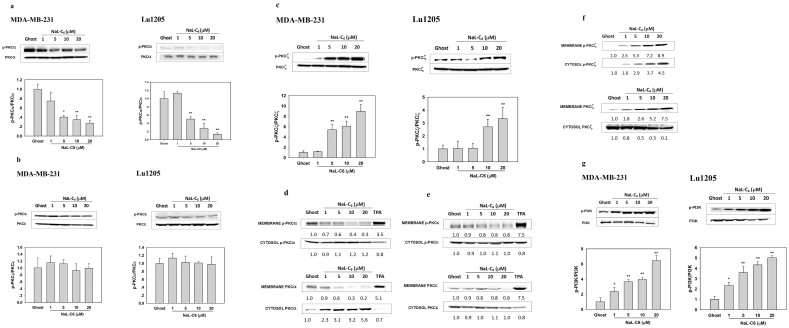
Nanoliposomal C6-ceramide induced phosphorylation of PKCζ nd PI3K as well as dephosphorylation of PKCα in a dose-dependent manner.(a–c) PKCζ was phosphorylated in response to acute NaL-C6-ceramide treatment. 1 μM, 5 μM, 10 μM or 20 μM NaL-C6 or ghost nanoliposomes were incubated with 1 × 106 MDA-MB-231 or Lu1205 cells for 30 min. Then, the cells were subject to western blotting analysis of (a) PKCα, (b)PKCε, and (b)PKCζ phosphorylation levels. Total PKCα, PKCε, and PKCζ were used as loading controls. Data represent three replicates. Densitometric analysis of phosphorylated PKC isoforms with respect to total PKC for each treatment was shown under blots. *p < 0.05, **p < 0.01 compared with ghost control. (d–f) PKCζ was translocated into MDA-MB-231 cell membrane in response to acute NaL-C6 treatment. After being incubated with various concentrations of NaL-C6 or ghost nanoliposomes, MDA-MB-231 cells were lysed and fractionated to cytosol and membrane components. Phosphorylated and total PKCα, PKCε, or PKCζ in cytosol and membrane fractionations were probed with western blotting. Data represent three replicates. (g) PI3K was phosphorylated in response to acute NaL-C6 treatment. MDA-MB-231 or Lu1205 cells were incubated with nanoliposomes in the same way as (a–c). Then, the cells were subject to western blotting analysis of phosphorylated and total PI3K. Data represent three replicates. Densitometric analysis of phosphorylated PI3K with respect to total PI3K for each treatment was shown under blots.*p < 0.05, **p < 0.01 compared with ghost control.